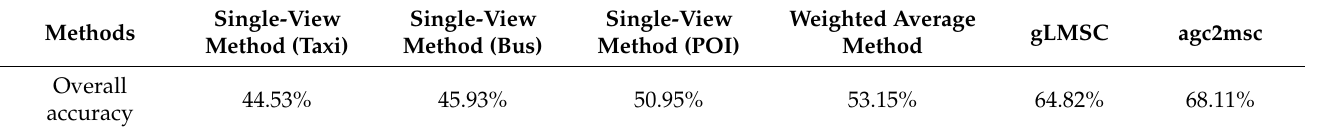
Figure 8. Clustering results by using different methods. ( a ) Single-view spectral clustering method using taxi GPS trajectory; ( b ) Single-view spectral clustering method using bus smart card transaction data; ( c ) Single-view spectral clustering method using POI data; ( d ) Weighted average spectral clustering method; ( e ) gLMSC; ( f ) agc2msc. Table 3. Overall accuracy of different